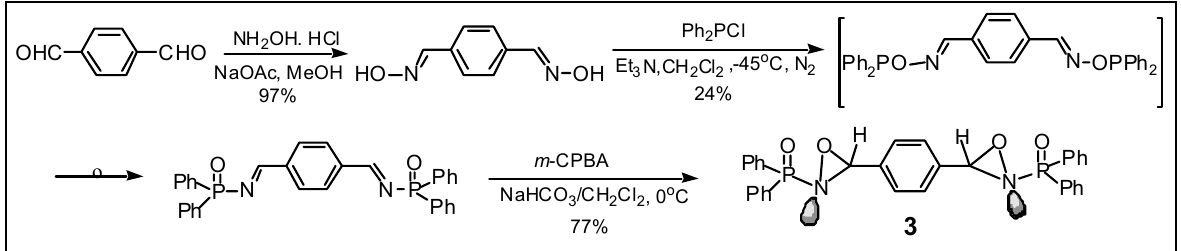
Scheme 2 . Synthesis of bisdiphenylphosphinoyloxaziridine, 3